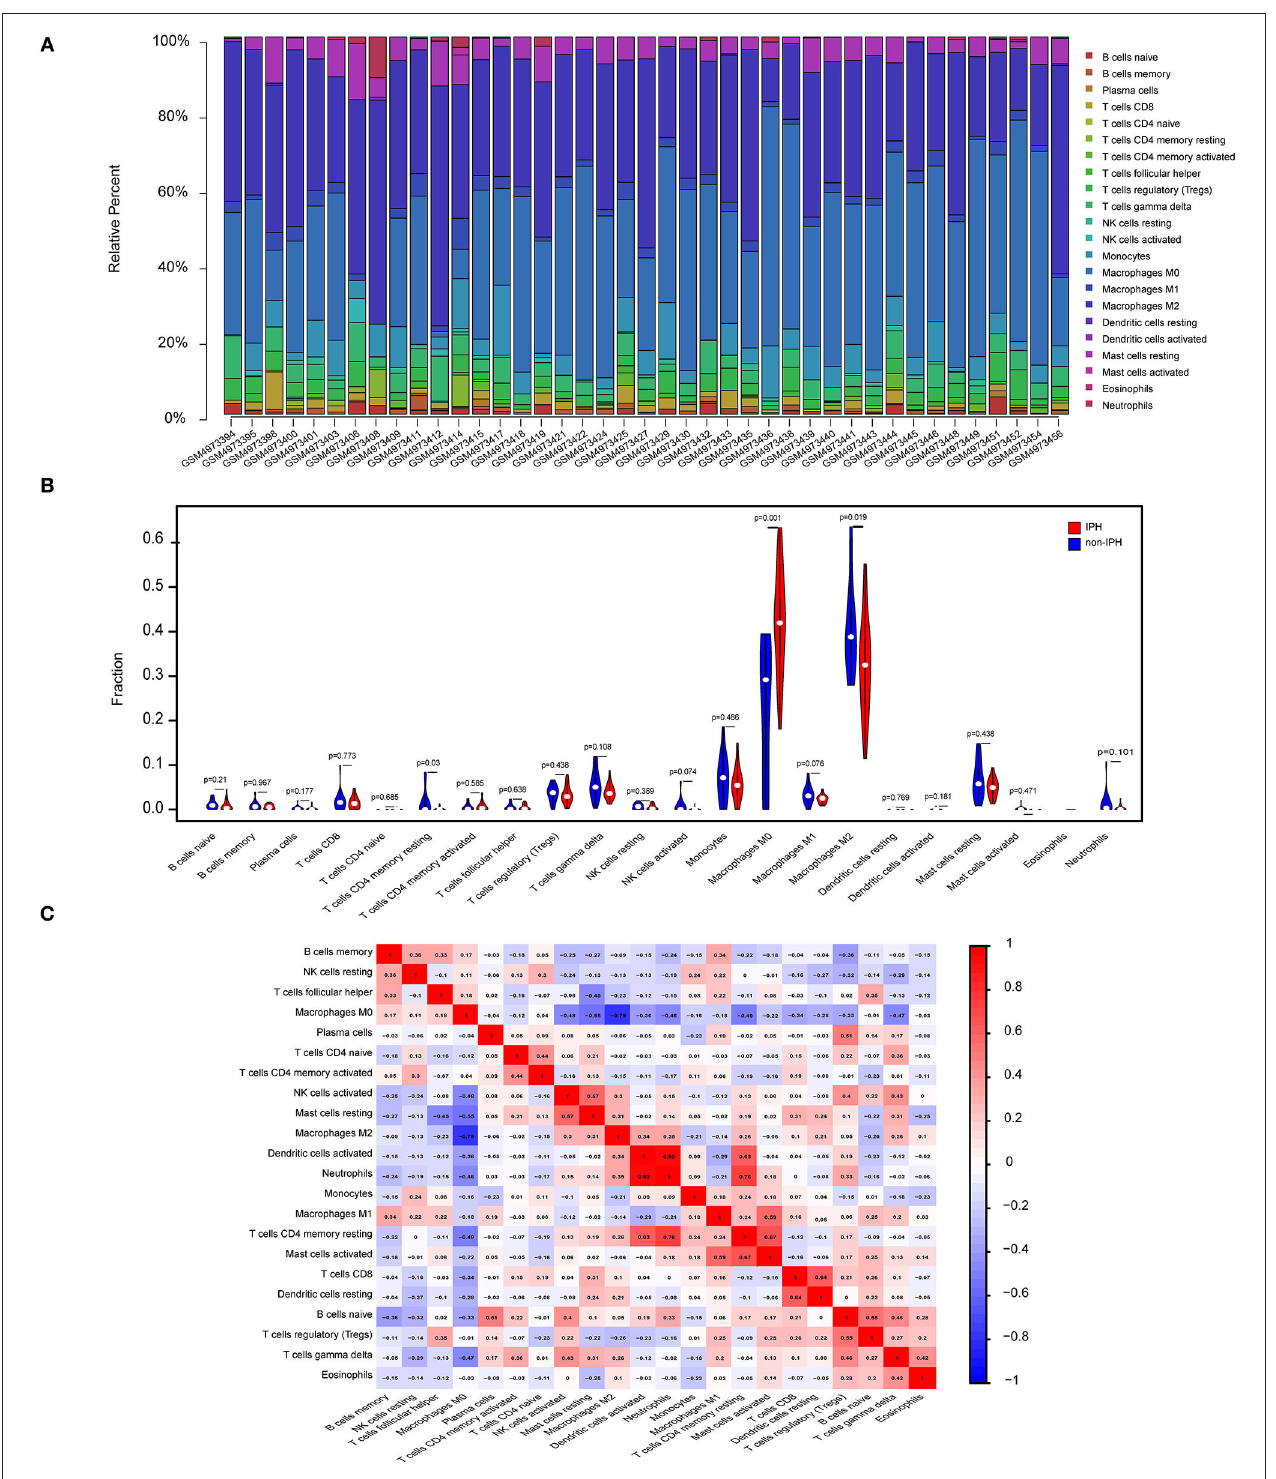
FIGURE 6 | Immune cell infiltration patterns in IPH samples and non-IPH samples. (A) Histogram of the proportions of 22 immune cell subpopulations in each IPH and non-IPH sample. x-axis: GEO samples; y-axis: percentage of each immune cell type. (B) Violin plot showing the differentially infiltrated immune cells between the two groups. Blue represents the non-IPH plaque group and red represents the IPH plaque group. (C) Correlation heatmap of all immune cells. Numbers in the small square represent Pearson’s correlation coefficient between the two immune cells on the horizontal and vertical coordinates; red squares indicate positive correlation, and blue squares indicate negative